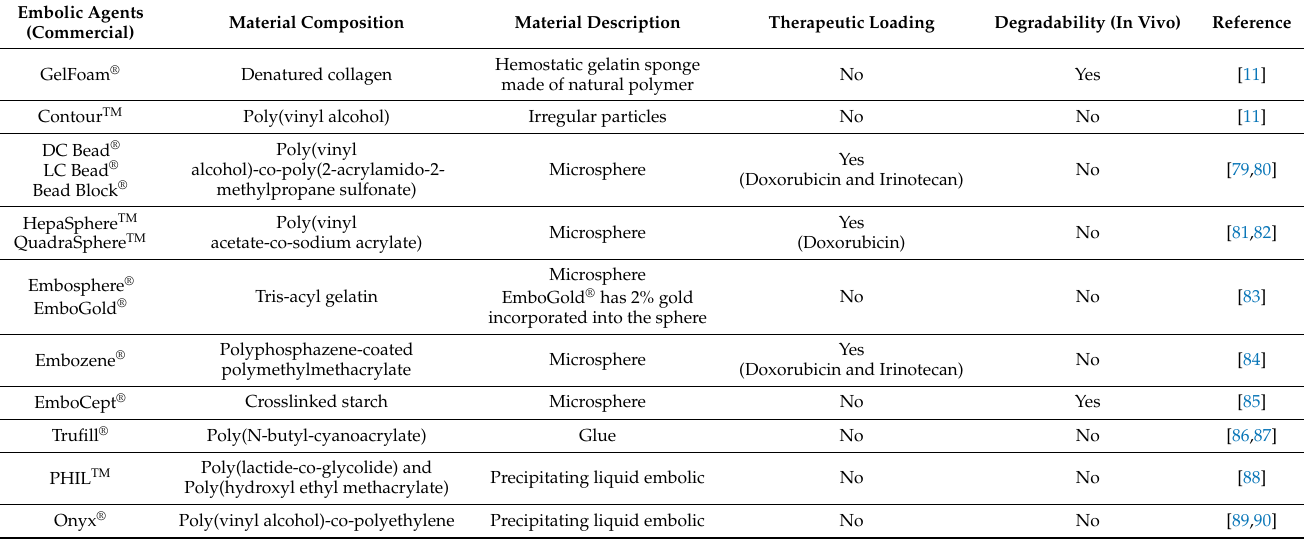
Table 2. Summary of commercially available polymeric embolic agents for